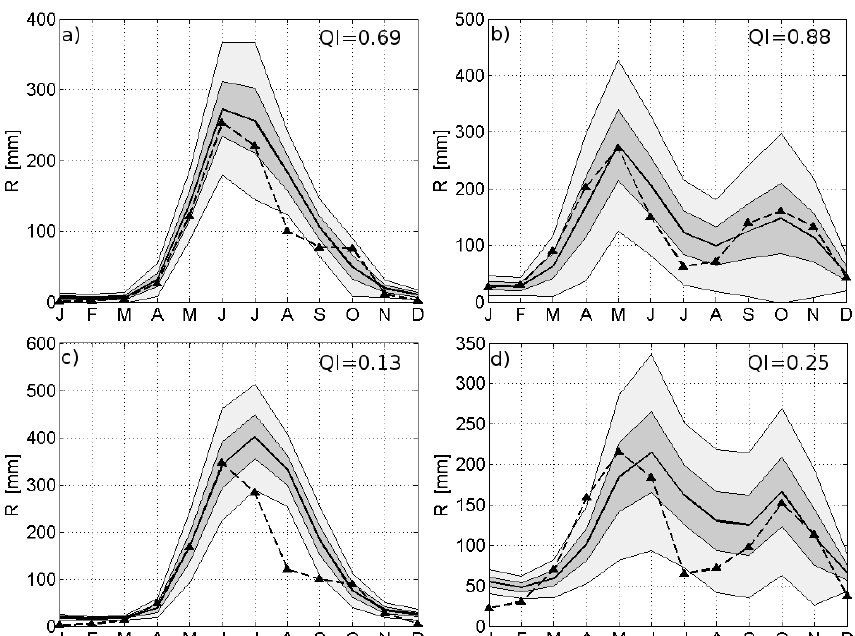
Fig. 6. Application at the regional scale. Observed (solid line) and simulated (dashed line) runoff regimes. Dark (light) grey area represents the confidence bands of the observed runoff at 40% (80%). (a) Savara at Eau Rousse; (b) Sesia at Ponte Aranco; (c) Rutor at Promise; (d) Toce at Candoglia. In the upper left corner of each panel a measure for the model performances, the Quality Index QI, is